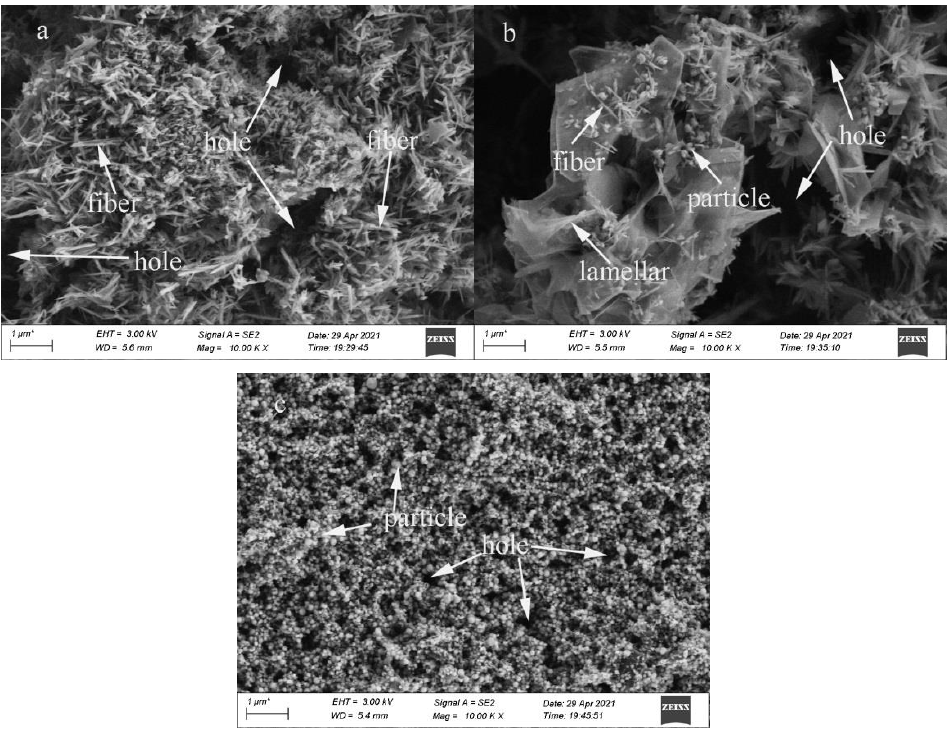
Figure 15. Surface morphology of SiC-hydroxyapatite coatings with different SiC particle (200 nm) concentration after dissolution: ( a ) 0.01 g/L; ( b ) 0.1 g/L; ( c ) 1 g/L